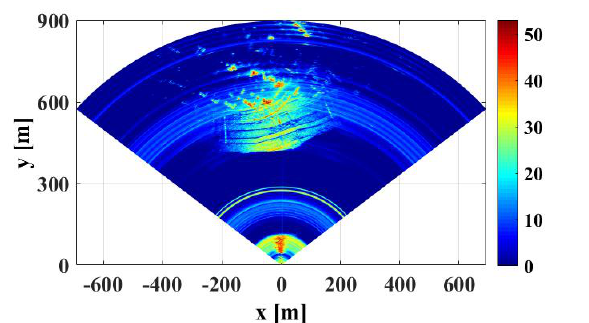
Table 1. Configuration for the measurement campaign